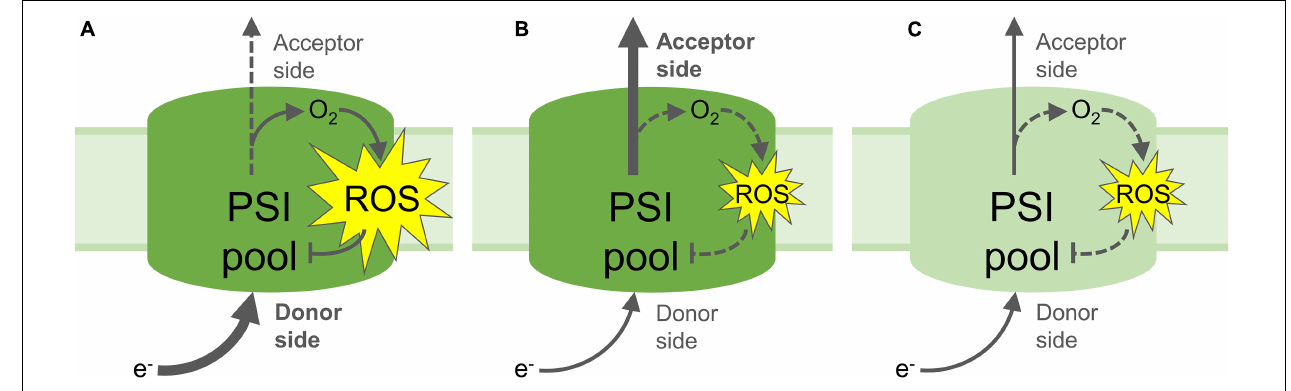
FIGURE 3 | Proposed mechanisms of PSI photoinhibition and photoprotection. (A) Increased electron flow to the PSI donor side and/or decreased flow from the acceptor side lead to reduction of O 2 and formation of reactive oxygen species (ROS), which result in inactivation of part of the PSI pool; (B) Non-photochemical quenching, photosynthetic control and/or PSII inactivation down-regulate the flow of electrons to the PSI donor side, limiting the formation of ROS and protecting PSI from photoinhibition. Upregulated electron acceptor capacity in the stroma through increased CO 2 fixation or photorespiration can also increase flow of electrons from PSI, which may also prevent ROS formation and protect PSI; (C) Partial inactivation of the PSI pool by PSI photoinhibition down-regulates transport of electrons to the acceptor side, limiting further PSI photoinhibition and down-regulating electron-consuming reactions in the stroma, including ROS formation and signalling. Yellow stars represent ROS production; Arrows represent electron flow, heavy arrows represent high rate of electron flow, dashed arrows represent low rates of electron flow. Pale green PSI pool (C) denotes partial inactivation of the PSI pool through ROS-induced FeS cluster and/or protein